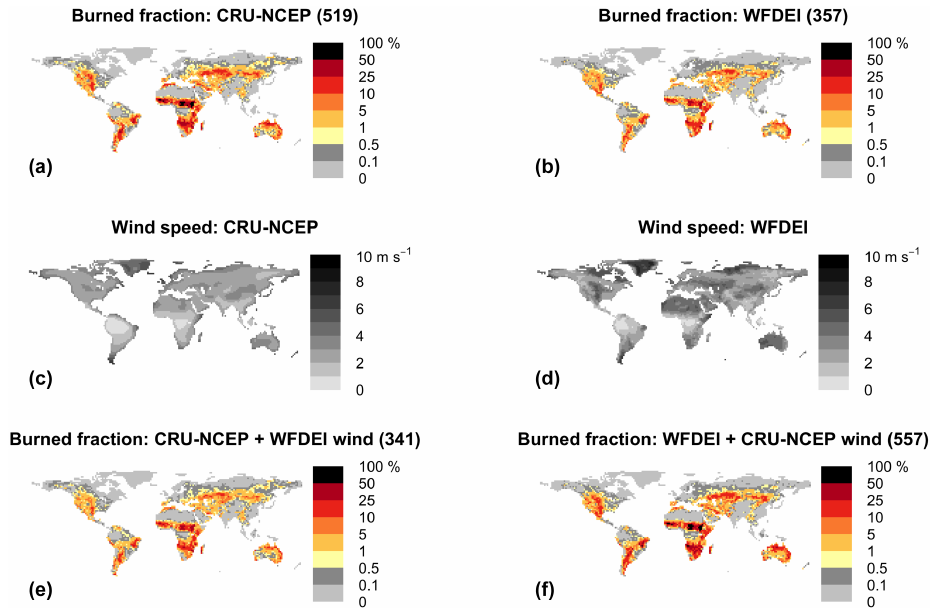
Figure 1. Comparing the effect of different wind forcing data on burned area simulated by JSBACH-SPITFIRE (Lasslop et al., 2014) over the years 1997–2005. (a–b) Annual burned fraction (%) modeled by JSBACH-SPITFIRE using (a) the CRU-NCEP forcing data (Wei et al., 2014) and (b) the WATCH (WFDEI) forcing data (Weedon et al., 2011). (c–d) Mean wind speed over the simulated period from (c) the CRU-NCEP and (d) WFDEI datasets. (e–f) Annual burned fraction (%) modeled by JSBACH-SPITFIRE with switched wind forcing: ( e ) CRU-NCEP except with WFDEI wind, (f) WFDEI except with CRU-NCEP wind. Numbers in sub-figure titles give mean annual global burned area (Mha) for each run.